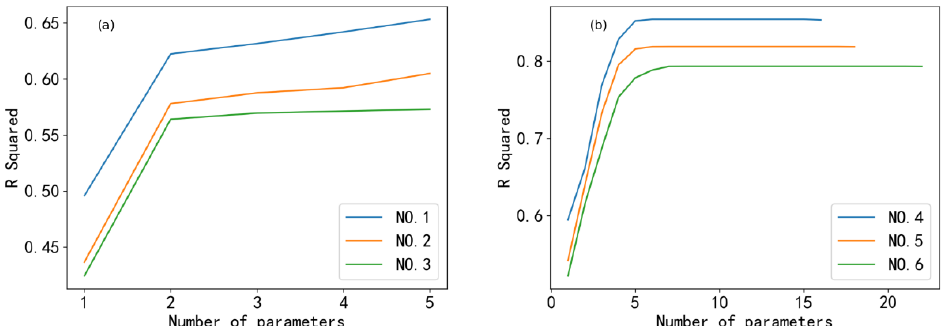
Figure 2. The relationship between the number of parameters in the stepwise regression model and the prediction accuracy of the model. ( a ) The results of the stepwise regression model using a single band or band combination spectral variables with different training datasets. ( b ) The results of the stepwise regression model using band combination and band ratio combination spectral variables with different training datasets. The experiment number corresponds to Table 3. The blue line corresponds to the 1-day time window dataset, the orange line corresponds to the 3-day time window dataset, and the green line corresponds to the 7-day time window dataset. Table 4. The optimal models of stepwise regression correspond to two groups of spectral variables and their related details. Group 1 represents the spectral variables that use a single band or band combination. Group 2 represents the spectral variables that use band combination and band ratio arrangement. The experiment number corresponds to Table 3.